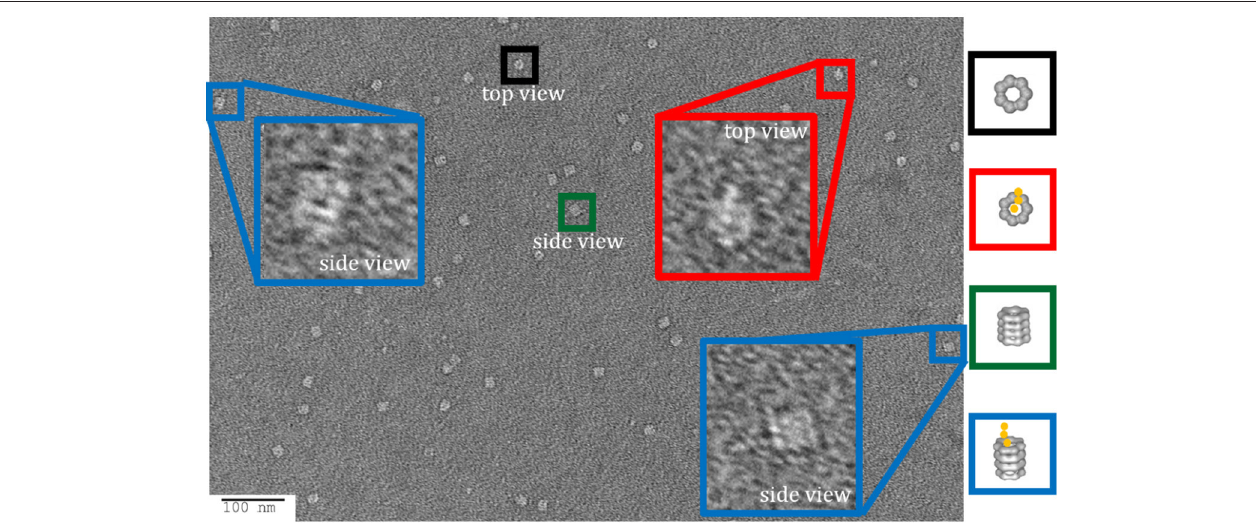
FIGURE 8 | Imidazole Release of GroEL-vWF Complexes from Ni-NTA Biosensor. Representative field of gridded and stained V1314D vWF-GroEL complexes formed after a 2M urea denaturant pulse. Multiple complexes can be seen as white on dark background. Top view of the complex is boxed in red, in which it is possible to observe the three domains of vWF. Side view of the complex is boxed in blue. Non-complexed GroEL top and side views are boxed in black and green, respectively. Micrographs obtained at KUMC.